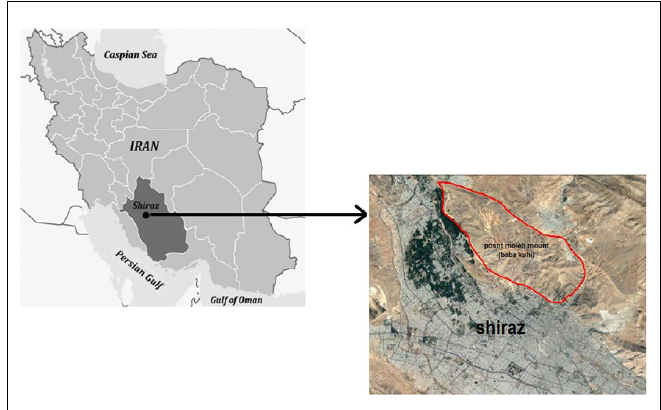
Figure 1. location of the study